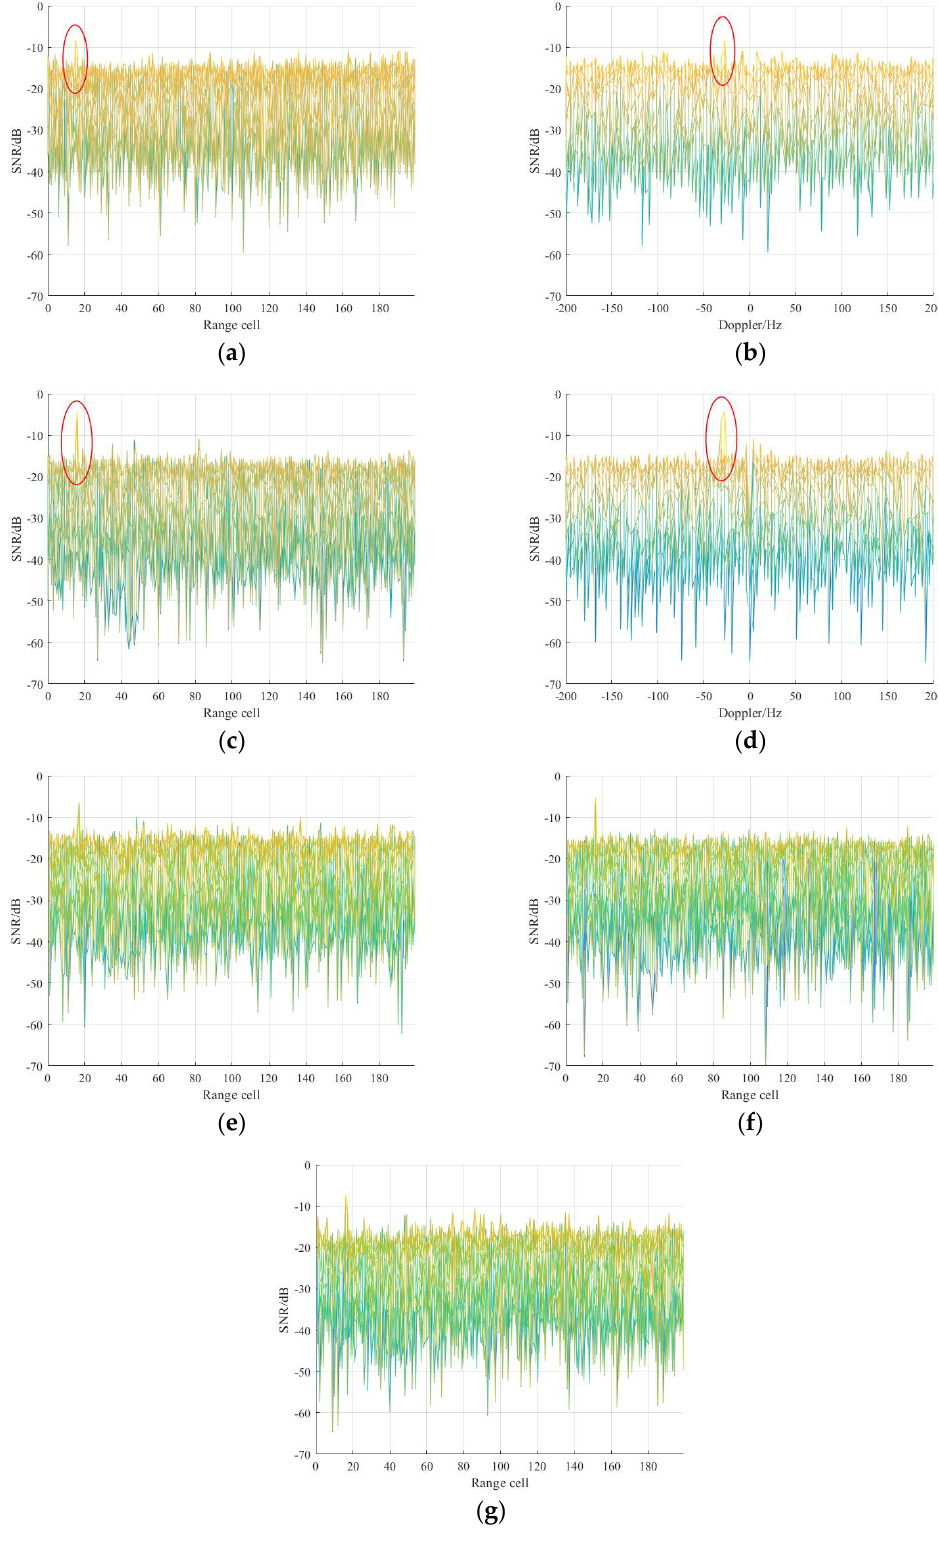
Figure 16. Target detection results of measured data using different purification method: ( a ) reference signal before pu-